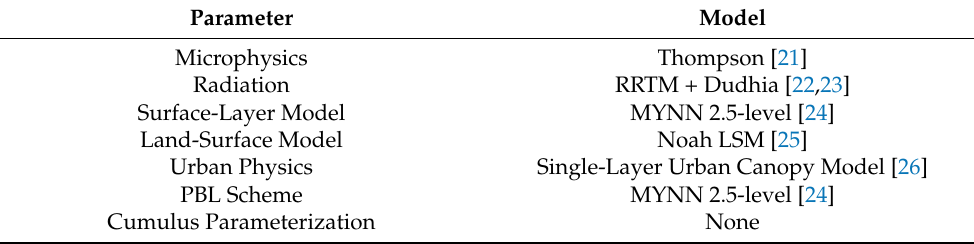
Table 2. The model parameterizations used in the WRF configuration for all the simulations done in this